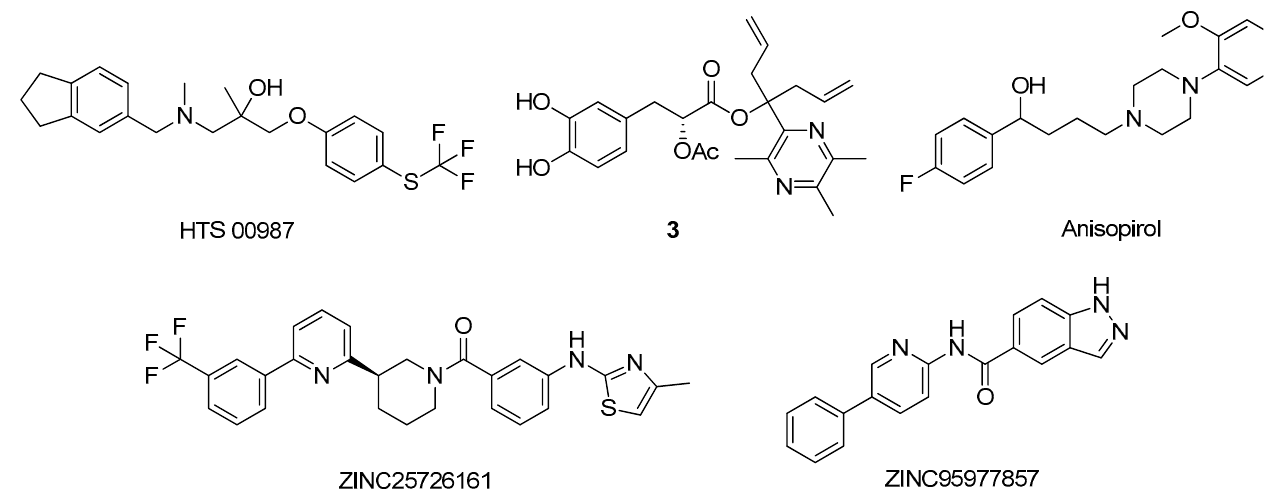
Figure 5. Structures of the studied NMDAR antagonists.